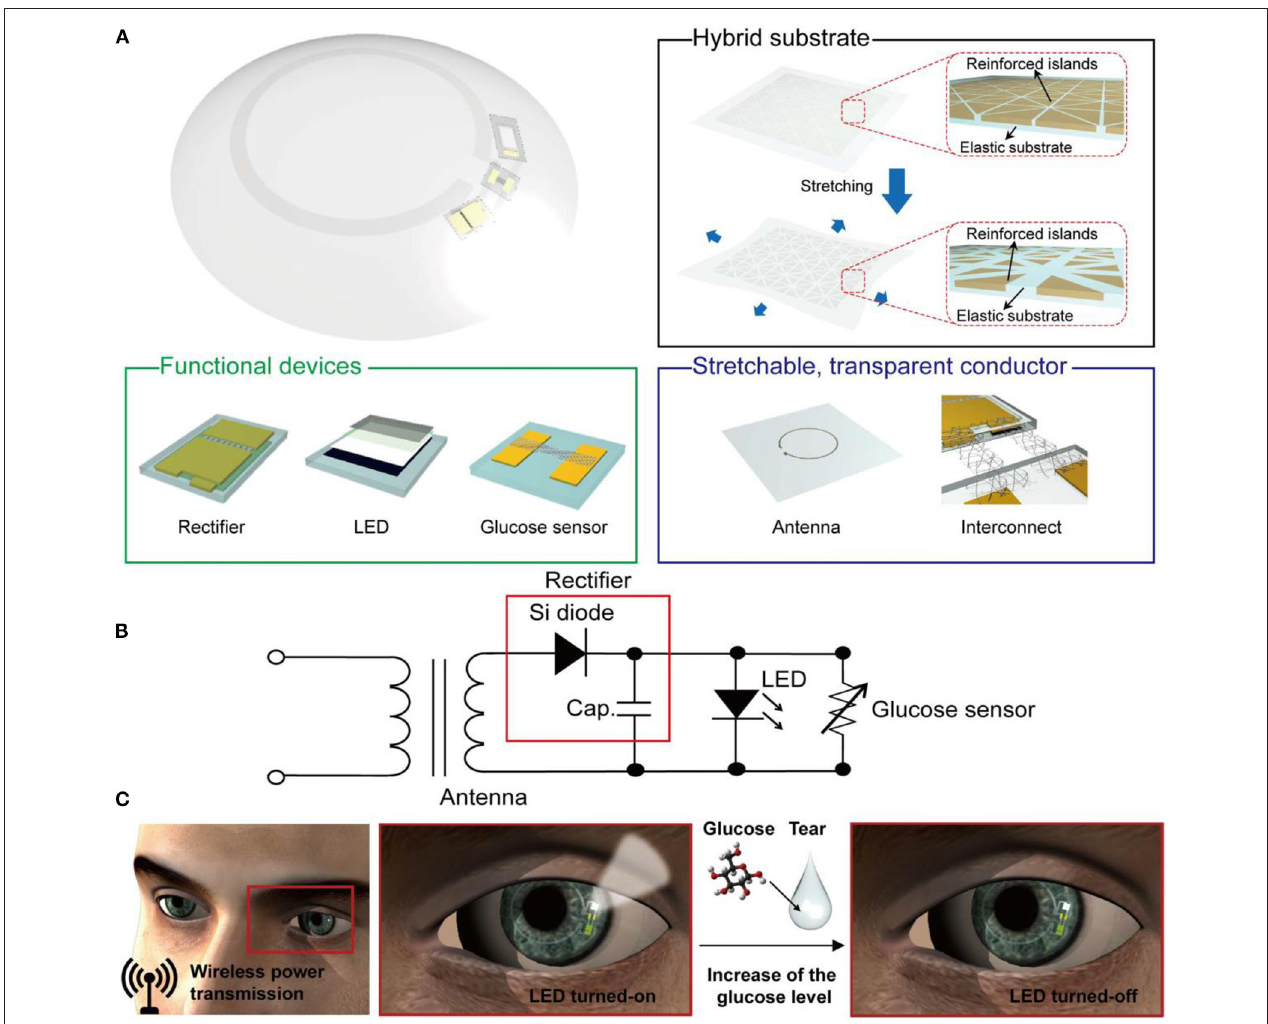
FIGURE 3 | A stretchable transparent smart contact lens system. (A) Schematic diagram of the soft contact lens; the lens is composed of a hybrid substrate, functional devise (rectifier, LED, and glucose sensor), and a transparent stretchable conductor (for antenna and interconnects). (B) A diagram of the circuit used in the smart contact lens system. (C) Operation of the smart contact lens; the electric power is wirelessly transmitted to the lens through the antenna, which in turn activates the LED pixel and the glucose sensor. The pixel turns off once the detected glucose level exceeds the normal limit